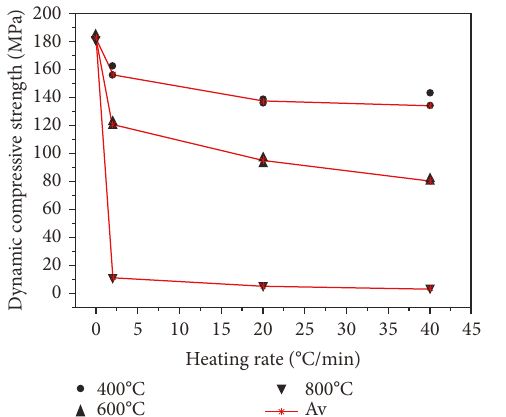
Figure 9: Calculation diagram of the dynamic elastic modulus.